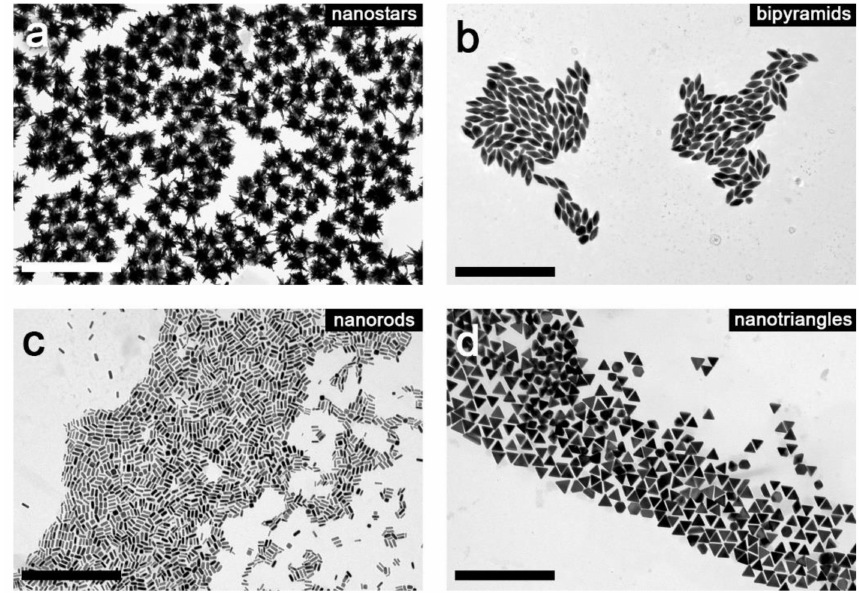
Figure 5. TEM micrographs of anisotropic gold nanoparticles: nanostars ( a ), bipyramids ( b ), nanorods ( c ), and nanotriangles ( d ). The scale bars on each micrograph represent 500